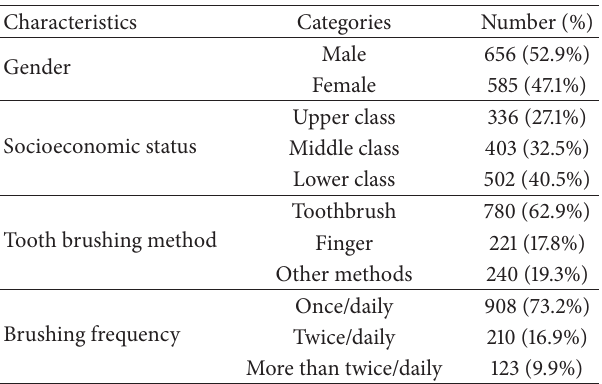
Table 1: Socio demographic characteristics and oral hygiene prac- tices of the respondents.